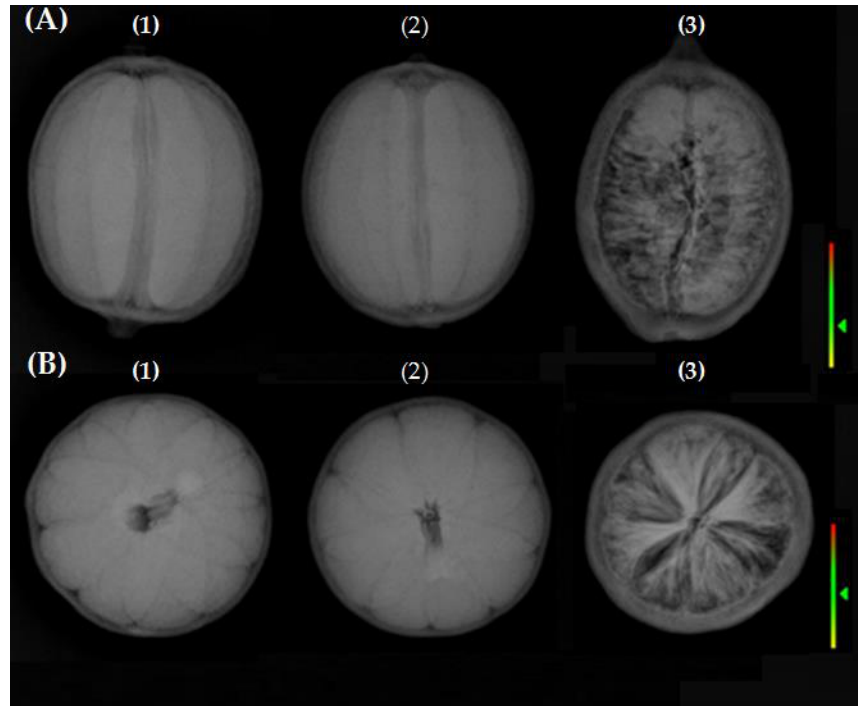
Figure 2. X-ray radiographic images of (1) fresh, (2) mature, and (3) overripe lemons acquired at ( A ) median-plane and ( B ) axial-plane of the lemons.